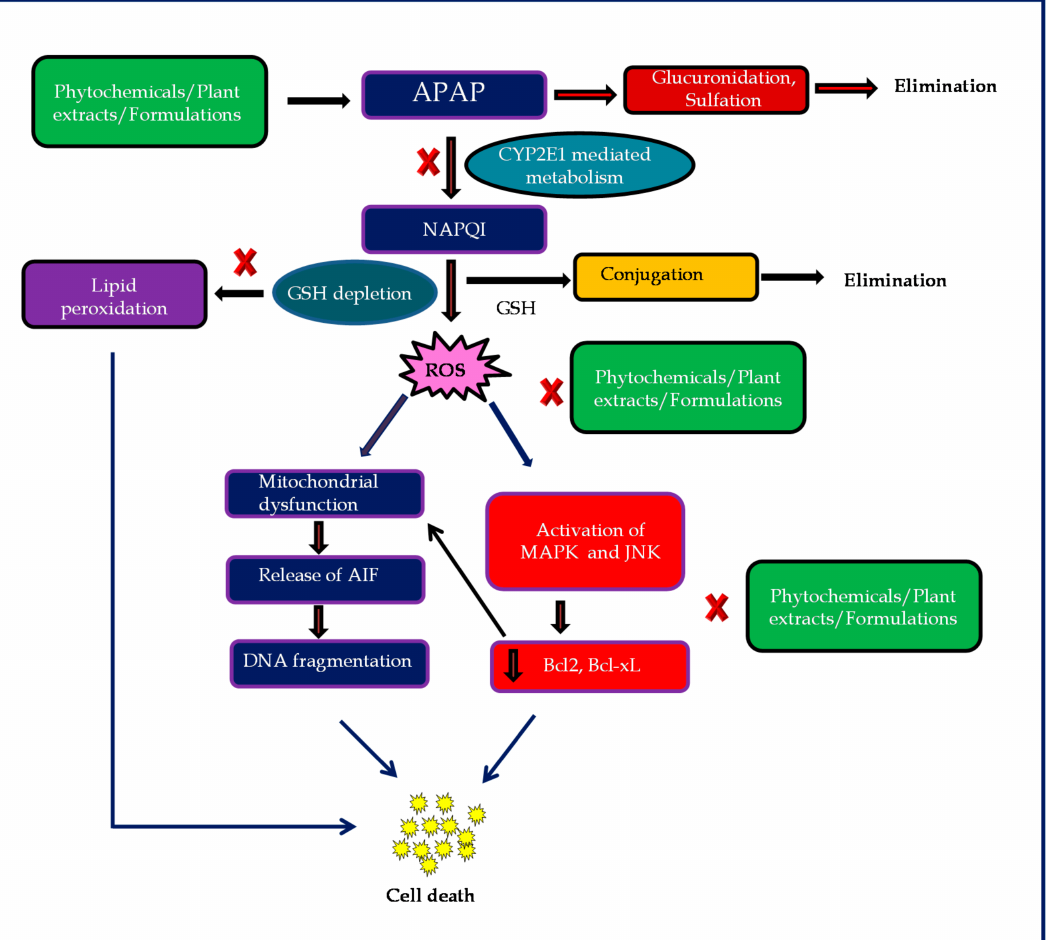
Figure 1. Schematic representation of phytochemical attenuate acetaminophen-induced liver